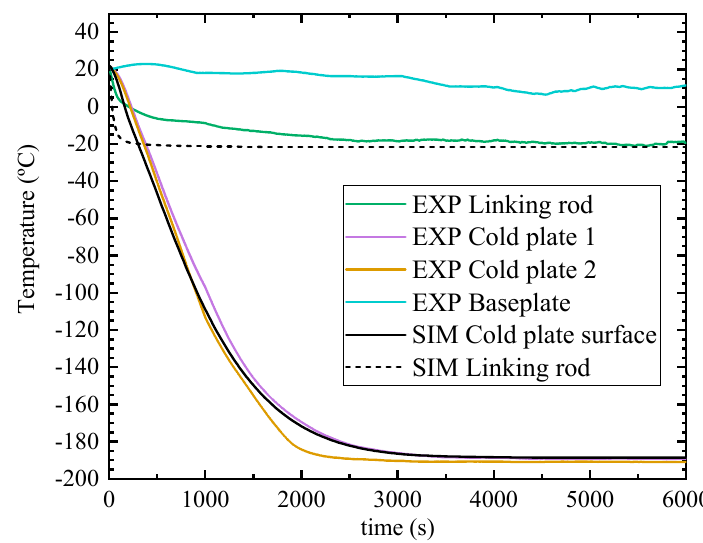
Figure 20. Experimentally measured and simulated temperatures.